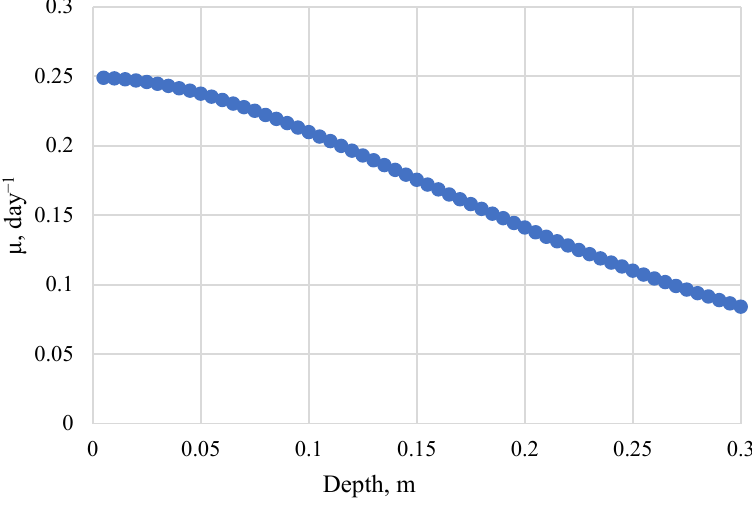
Fig. 6. Calculation of the growth rate depending on z (depth) and light intensity according to Steel’s formula [58]. From the implementation of Steel formula (Eq. (4)) Fig. 6 explains well the prevalence of the effects of light-limitation (from the ratio I / I op ) rather than